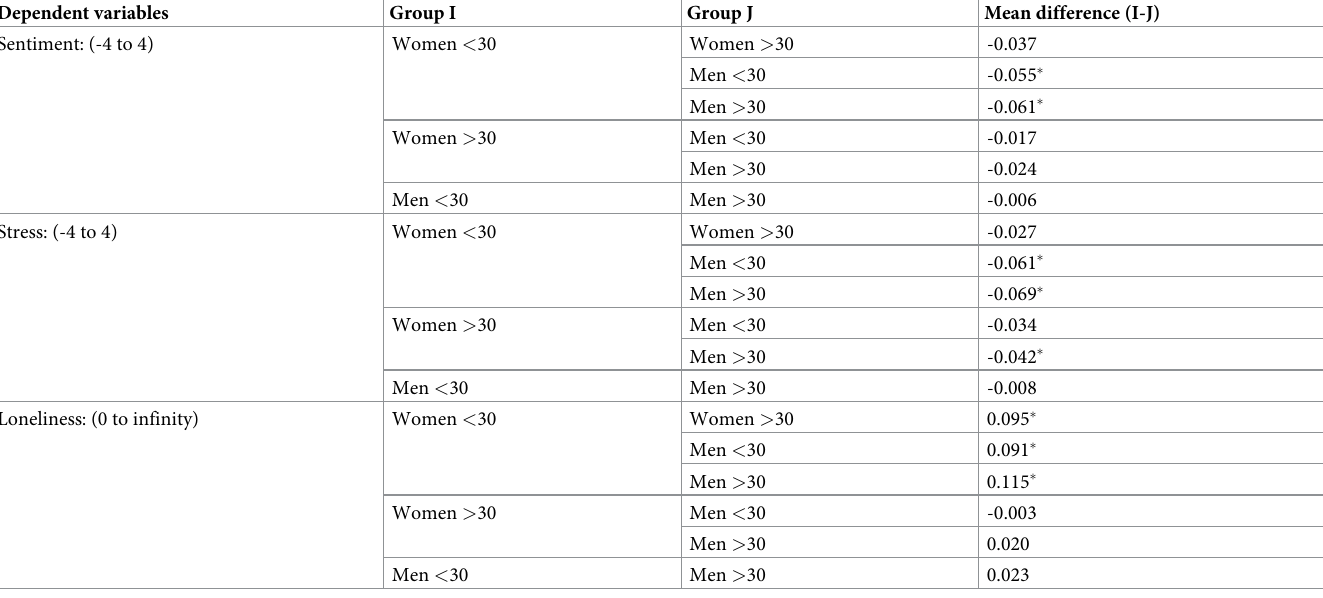
Table 4. Multiple comparisons using Tukey’s HSD post hoc